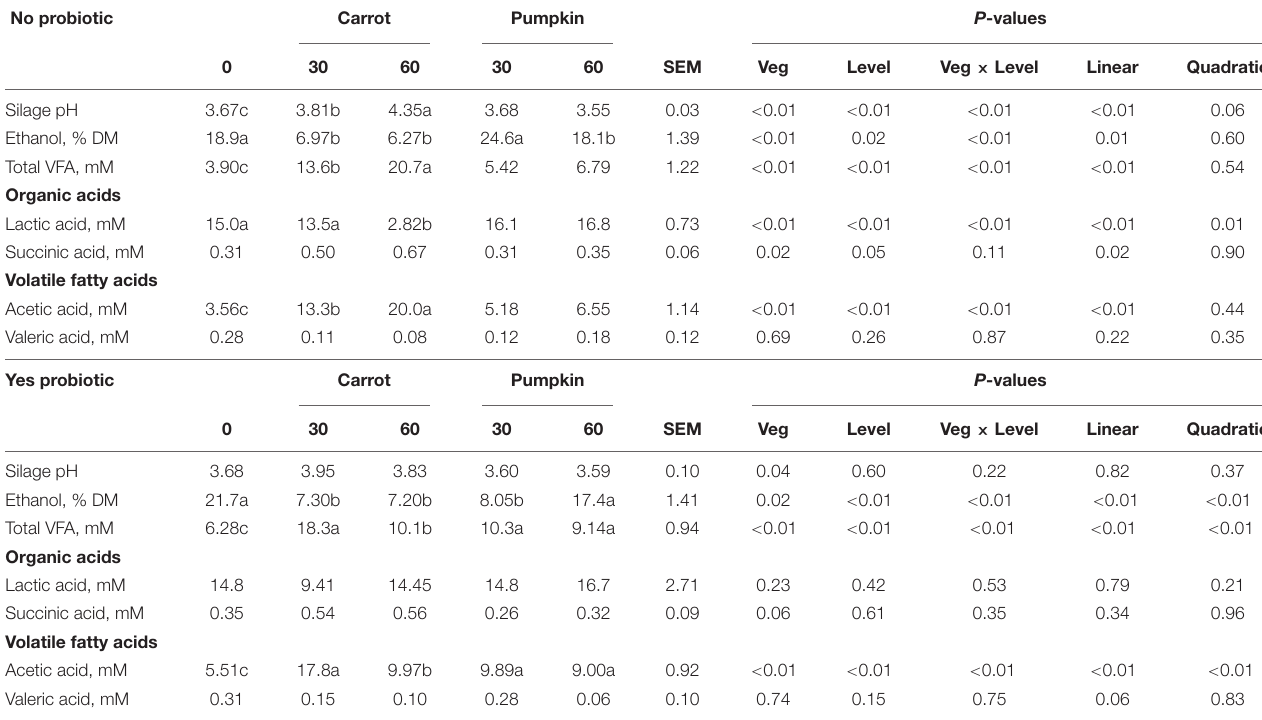
TABLE 2 | Fermentation parameters of sorghum combined with carrot or pumpkin at 0, 30, or 60% DM after 70 days of ensiling, split by with probiotic (yes) or without (no). No probiotic Carrot Pumpkin P -values